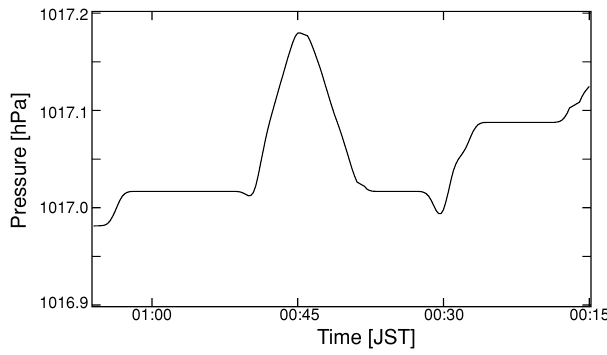
Fig. 12. Time series traces of the surface pressure recorded at the AO from 00:15 to 01:05 JST on 30 December 1997. Time runs right to